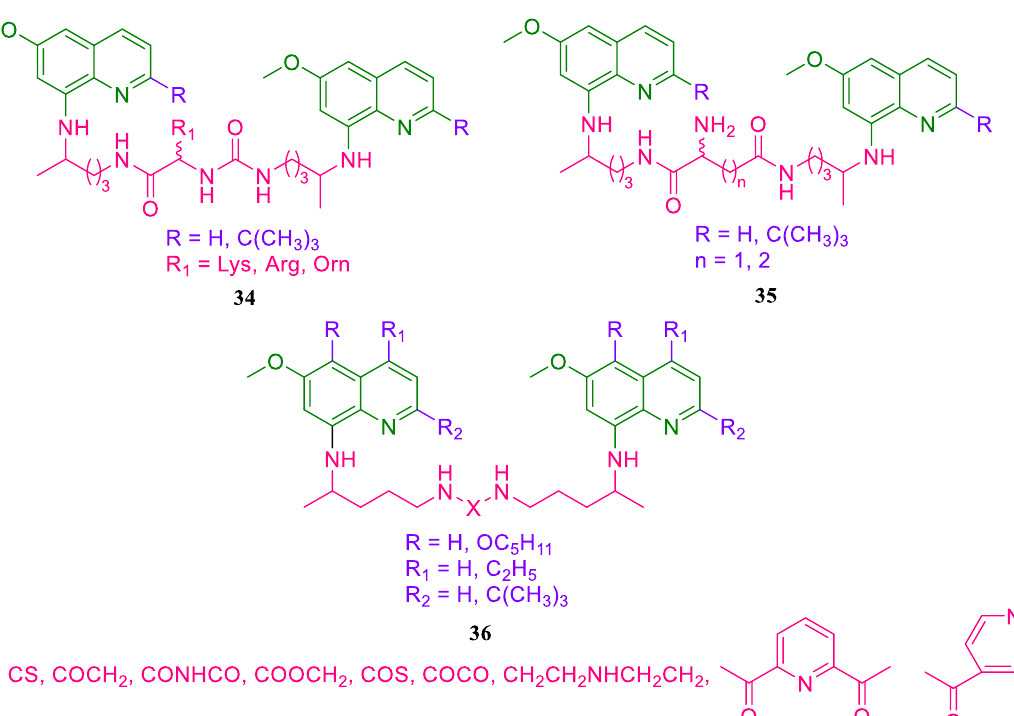
Figure 37. Amino acids/peptides conjugated bis- 8-aminoquinolines.